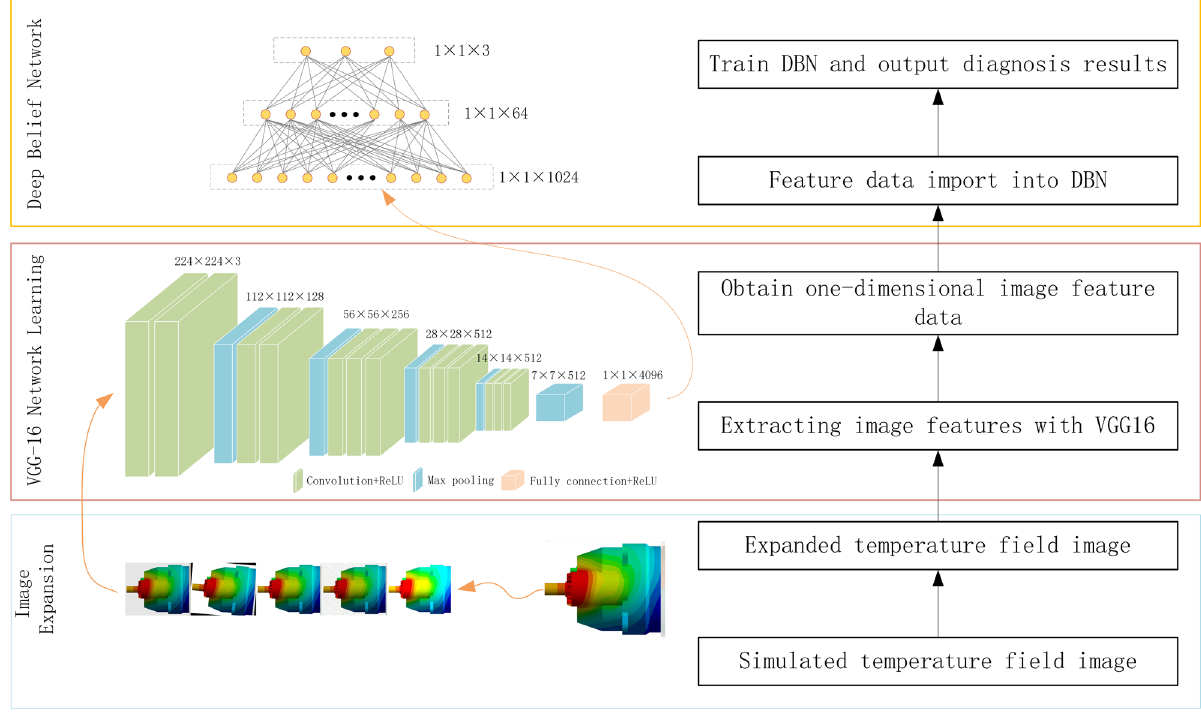
Figure 3. The structure of